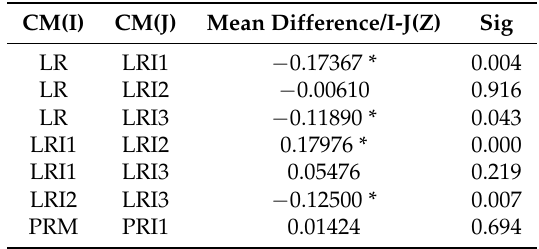
Table 4. Post hoc Test for different combinations of coding parameters with LSD correction.